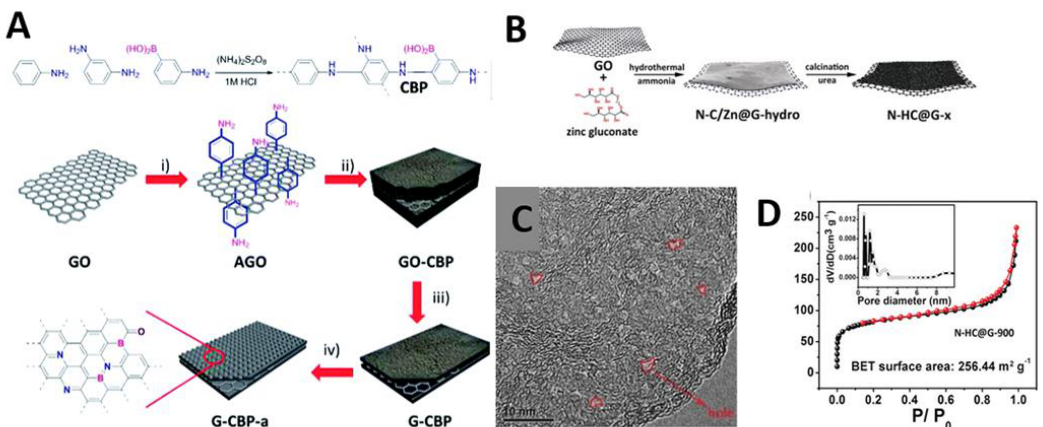
Figure 4. ( A ) Scheme of the preparation of N-doped mC/G and B/N-co-doped mC/G nanosheets. Licensed under CC-BY from Ref. [84]. ( B ) Scheme of the fabrication of ultrathin N-doped holey carbon layer on GO. ( C ) High-resolution TEM (HRTEM) image of N-doped holey carbon layer on GO with red cycles showing the nanoholes formed. ( D ) N 2 adsorption/desorption isotherms of N-doped holey carbon layer on GO. ( B – D ) Reprinted with permission from Ref. [80], Copyright (2018) John Wiley and Sons.